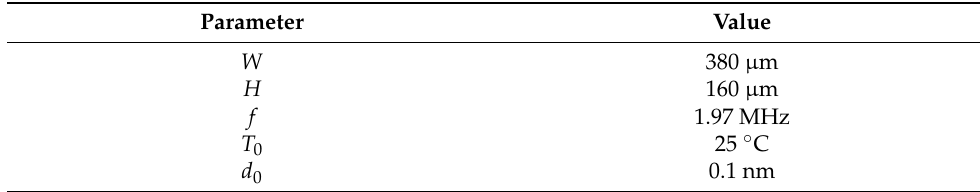
Table 3. Parameters of the model used in Ref. [43], which have been re-simulated here.